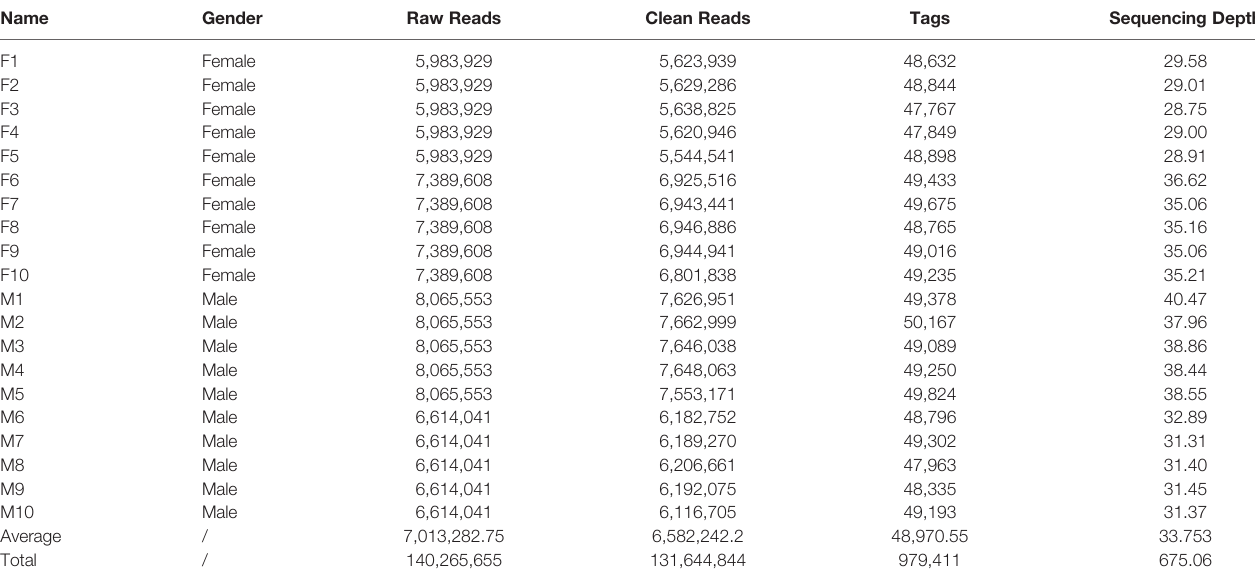
TABLE 1 | Summary of 2b-RAD data obtained from 10 male and 10 female Strongylocentrotus intermedius